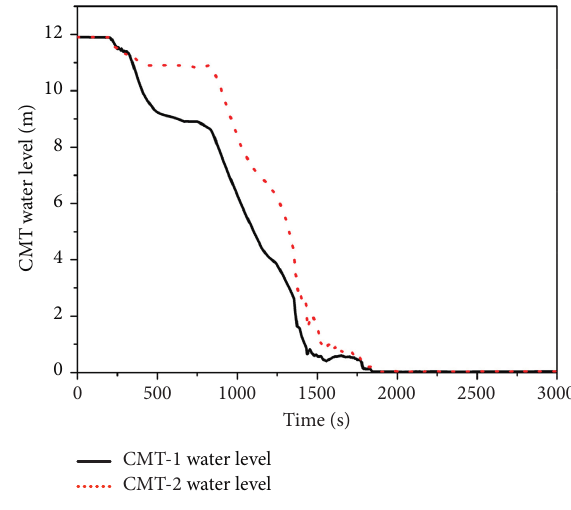
Figure 15: 2-inch CL break CMT water level.